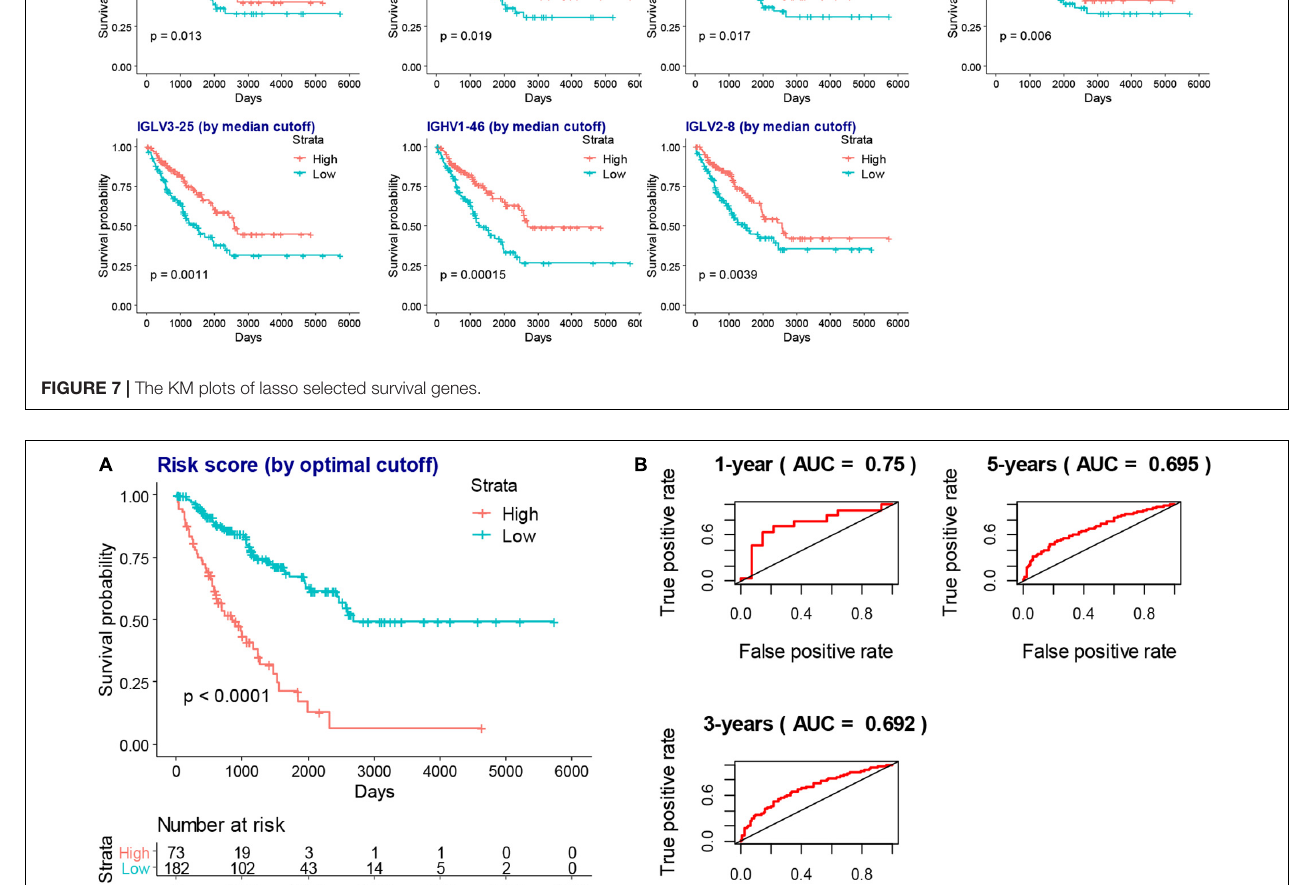
involved in processes that promote adipocyte